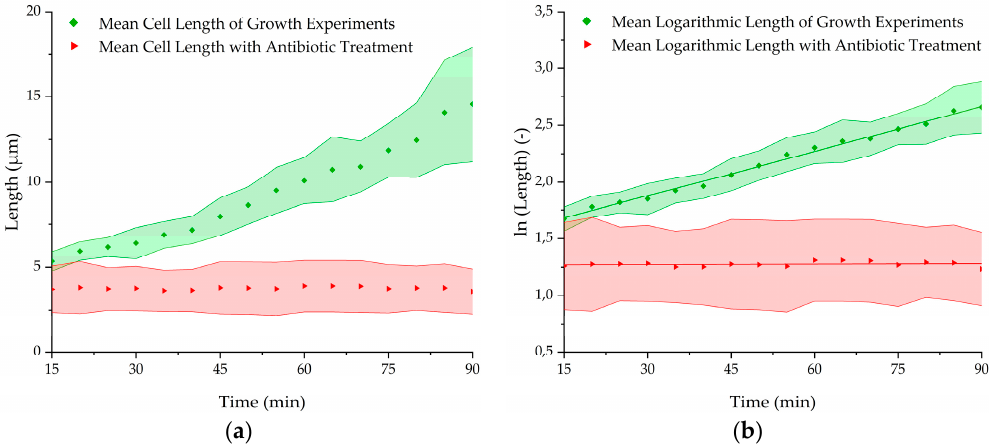
Figure 8. ( a ) Mean length growth, ( b ) mean logarithmic length growth with and without 200 µg/mL kanamycin in TB medium at 37 °C at the nanogap. Statistical significance was tested using two-sample t-test with a significance level of 0.01. Calculated p-values (<0.01) indicate that the growth rate of the antibiotic treated bacteria (n = 4) differs significantly from the population without treatment (n = 5).